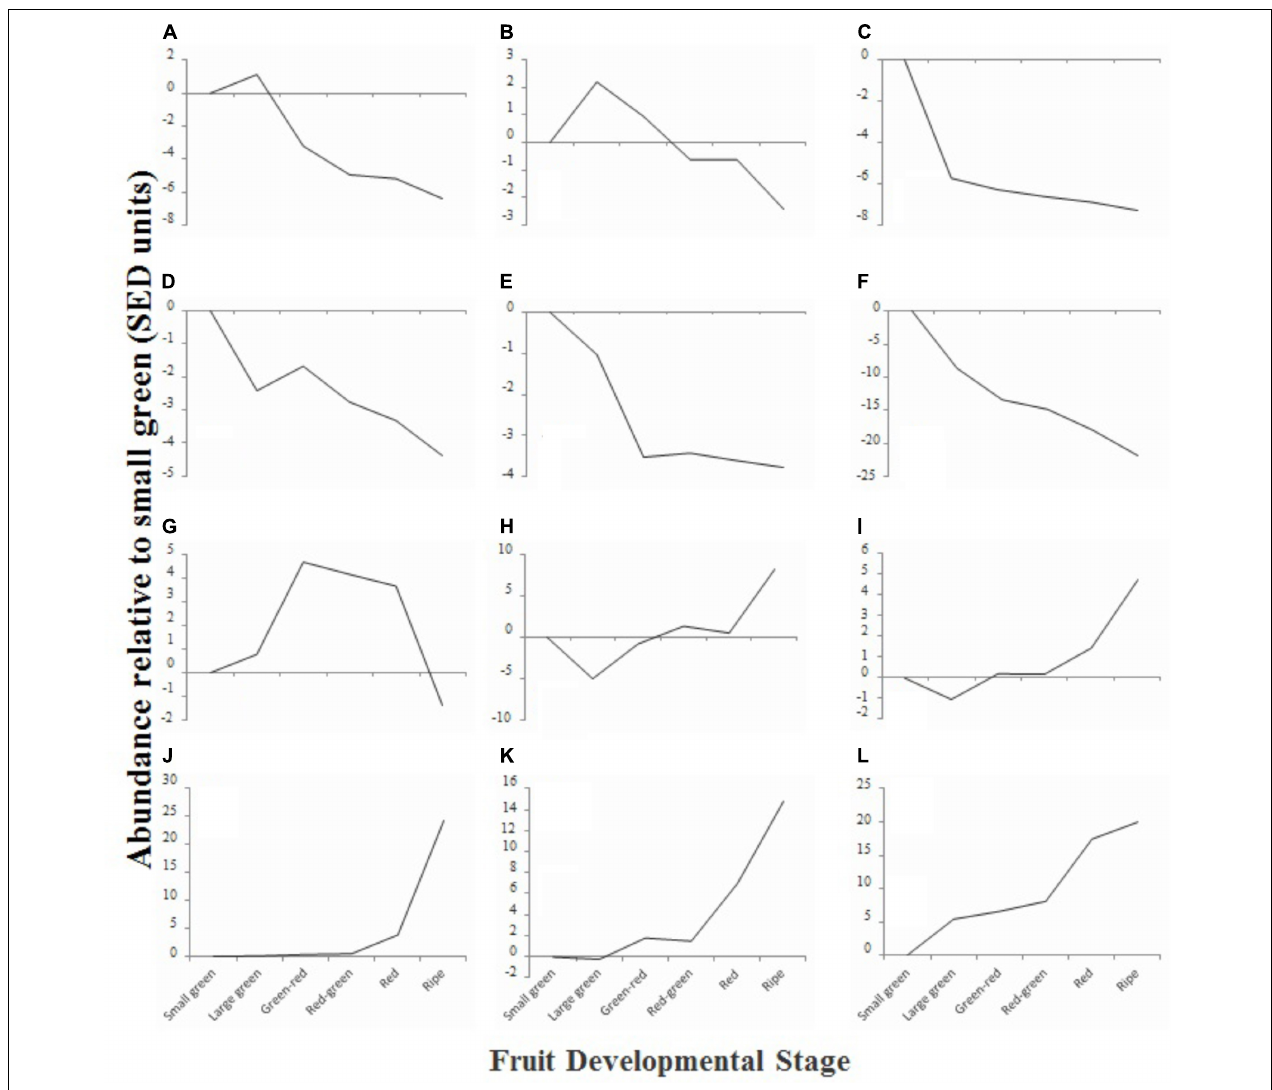
FIGURE 4 | Relative average abundance of metabolite clusters identified by hierarchical cluster analysis at six stages of blackcurrant fruit ripening. Clusters were identified at an initial cut-off of 96% similarity with additional manual adjustment based on visual assessment of similarity dendrogram and are identified in the text as labeled (A–L) . Data are represented as the average change of abundance of compounds present in the cluster relative to average abundance in small green fruit. Data were normalized based on standard errors of difference (SED) as described in materials and